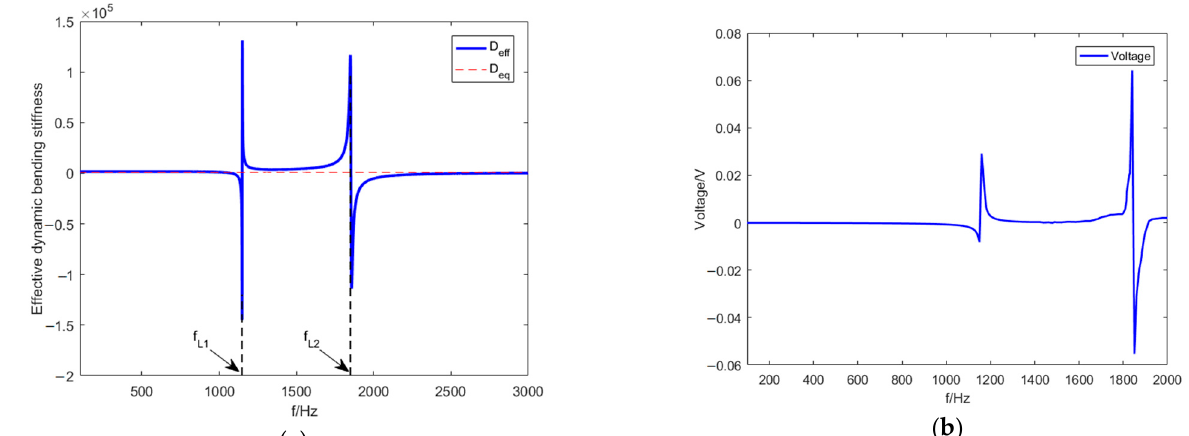
Figure 9. Lattice constant/length of the curved wave.